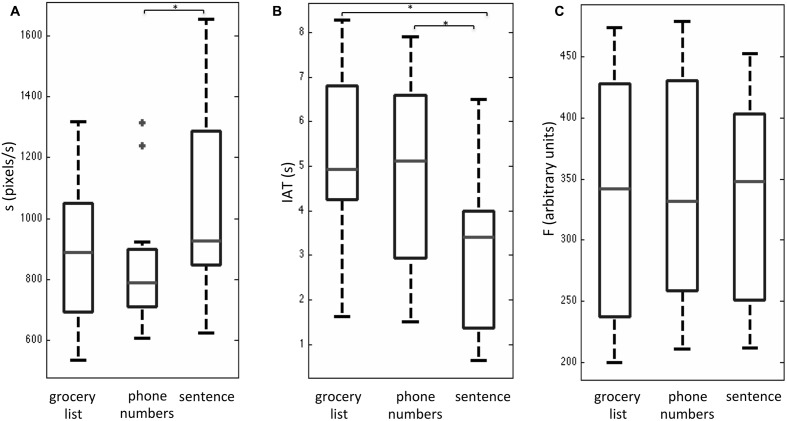
Box and whisker plots of behavioral performance metrics (A) handwriting speed s, (B) stylus in air time, IAT, and (C) stylus contact force, F for three handwriting tasks during fMRI, involving copying a grocery list, phone numbers, and a sentence. For each box, the interior horizontal line shows the median value, and edges of the box are estimates of the first and third quartile. The whiskers extend to the most extreme data points not considered outliers (2.7 times the sample standard deviation assuming a normal distribution). Outlier points are shown as crosses. Statistically significant differences between tasks (p < 0.05) are indicated by an asterisk.